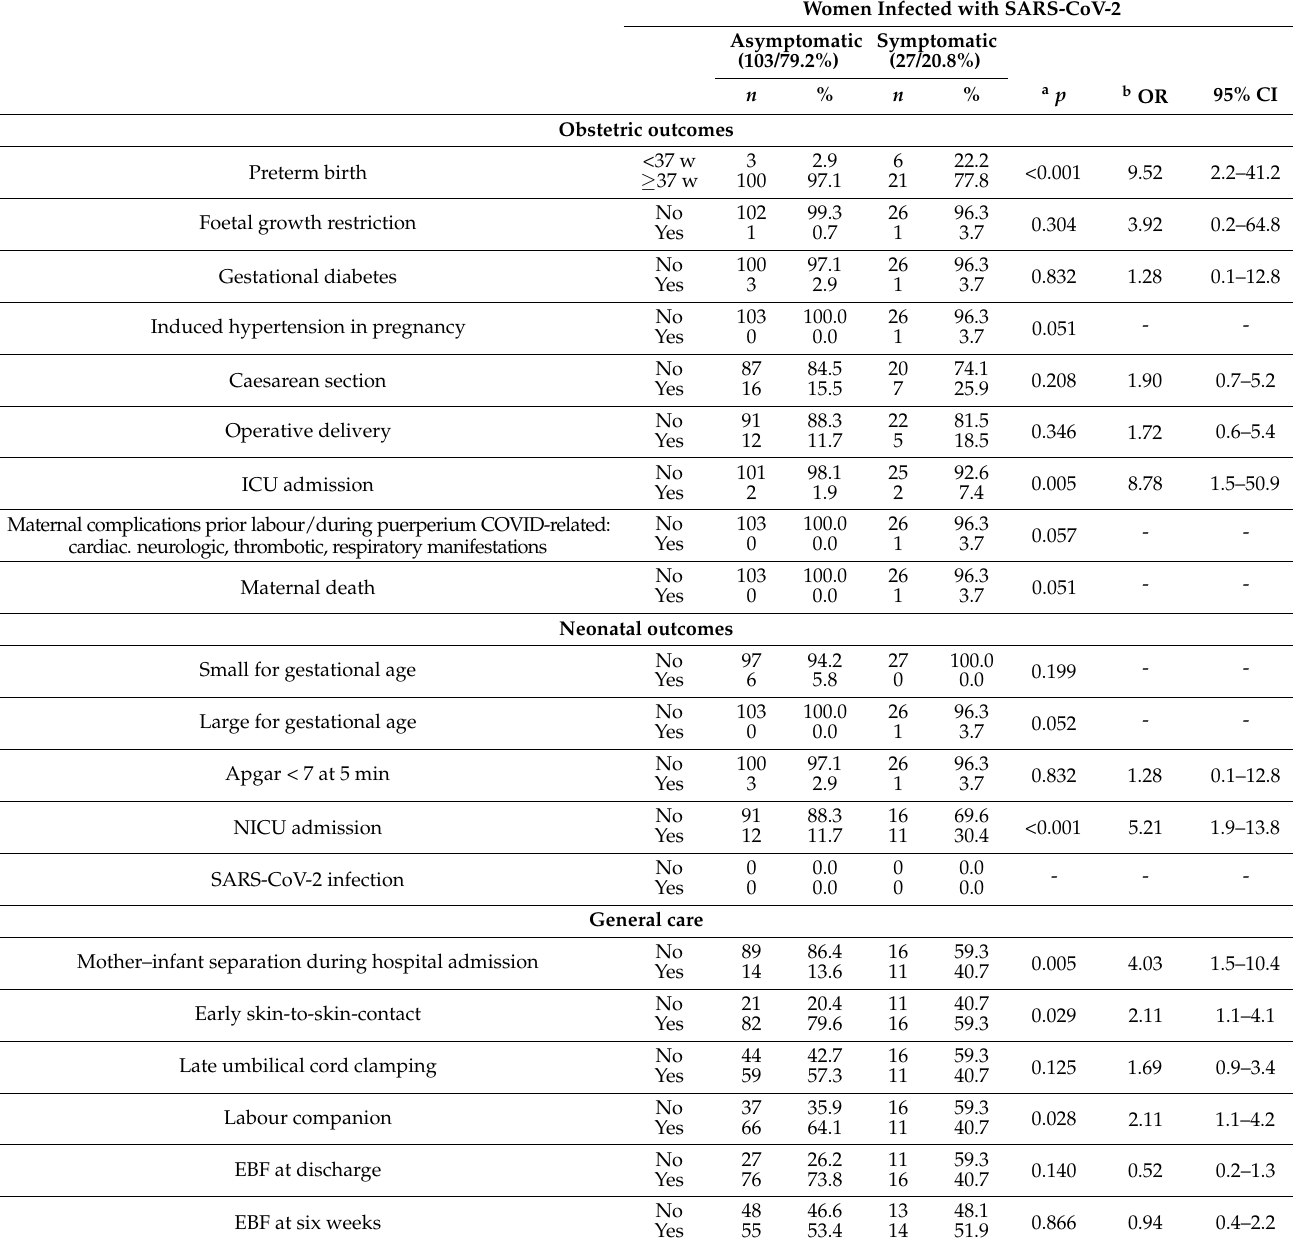
Table 5. Obstetric–neonatal outcomes and general care of the participants. Women Infected with